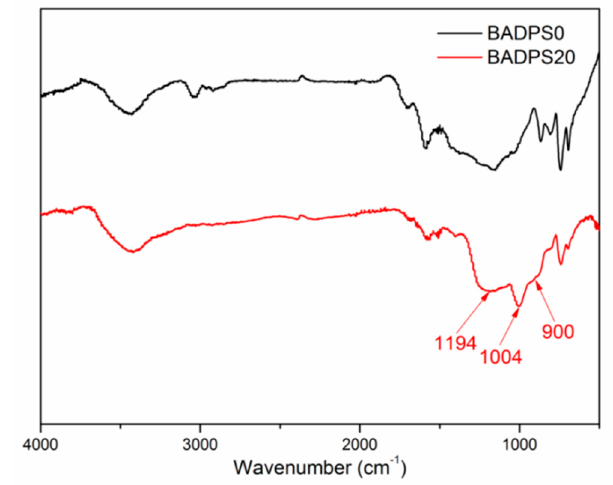
Figure 11. FTIR spectra of char residues for BADPS0 and BADPS20.